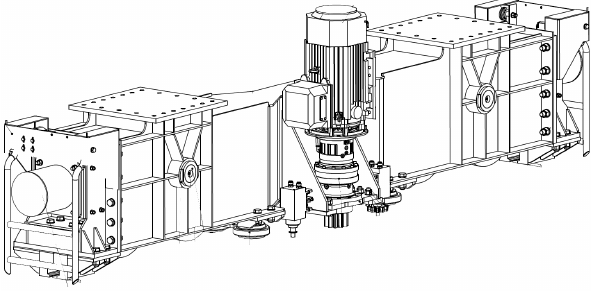
Figure 5: The carriage assembly